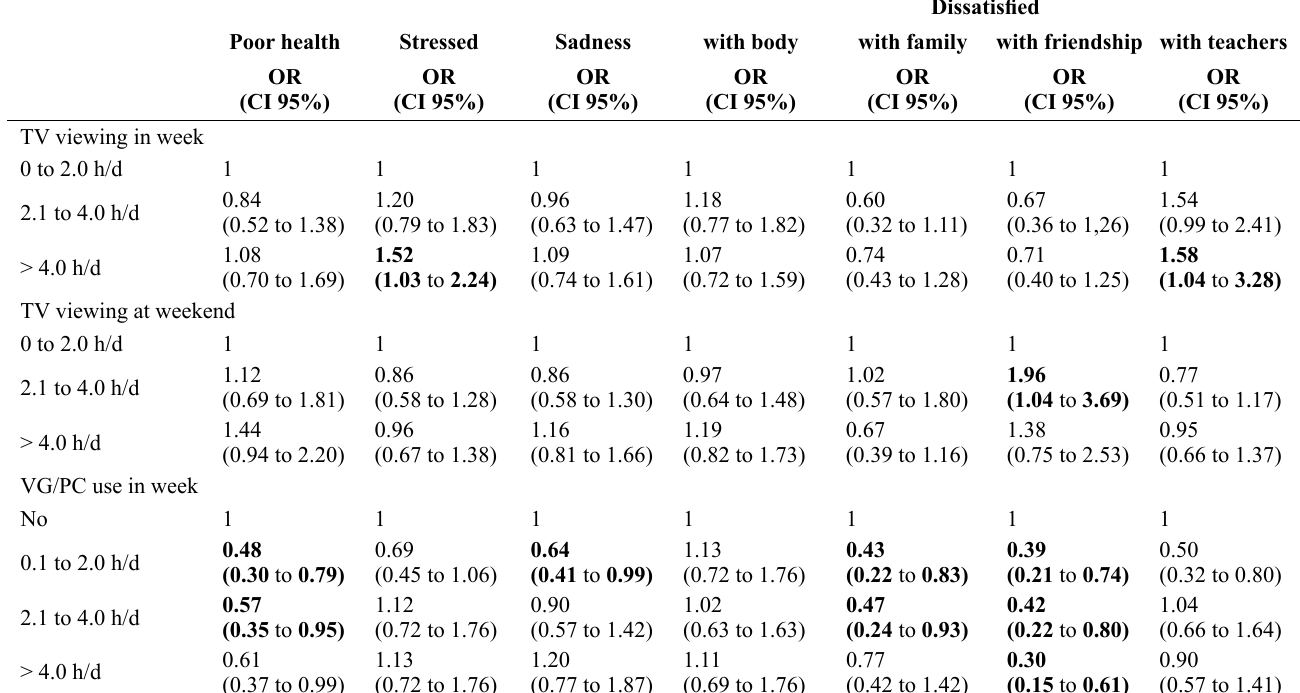
Table 3. Association between sedentary behavior contexts and indicators of mental health and social relationships in girls (Londrina 2011, Brazil; n =